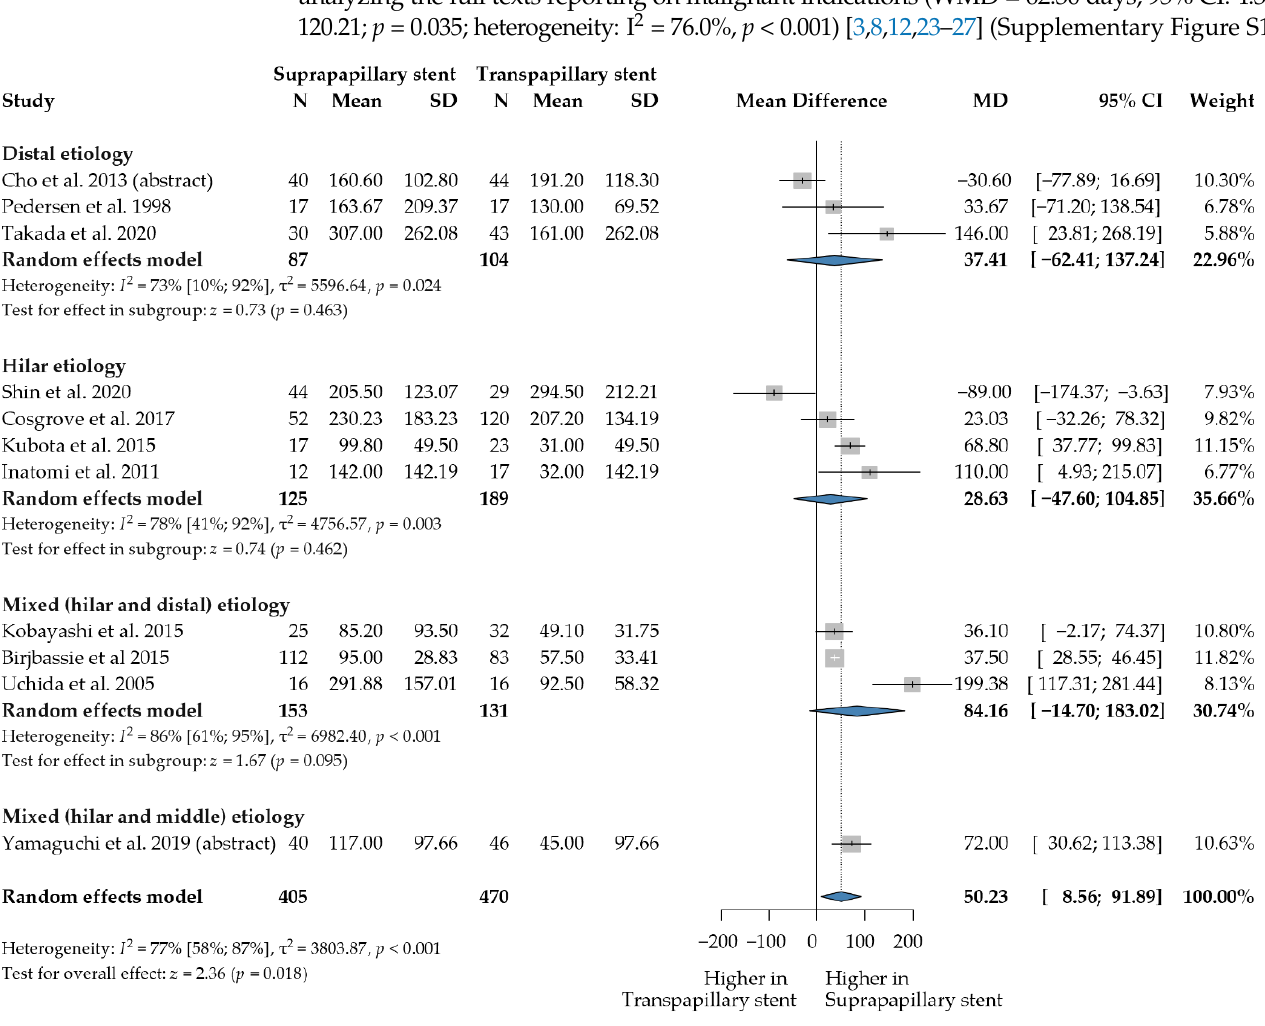
Figure 2. Forest plot comparing the stent patency time between suprapapillary and transpapillary stents. Unit of measurement: days. WMD: weighted mean difference; p : p -value; CI: confidence interval; I-squared: I 2 . [3,8,12,22 – 28,31]